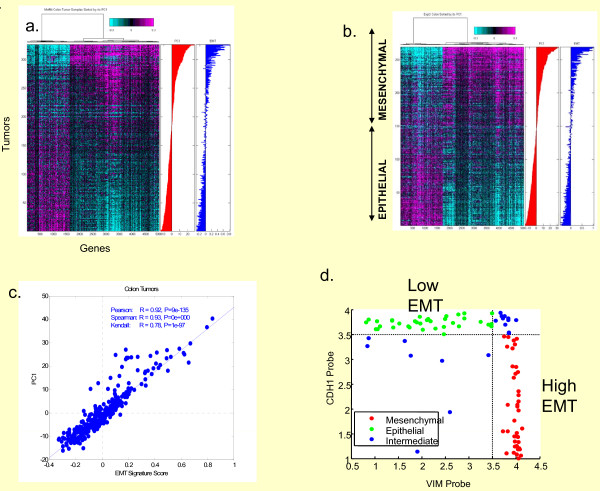
Intrinsic molecular stratification of human colorectal cancer. Unsupervised analysis and hierarchical clustering of global gene expression data derived from colorectal cancer cases identified 2 major "intrinsic" subclasses (cyan and magenta) distinguished by the first principal component (PC1) of the most variable genes. These two key native subtypes were clearly identified in both the (a) Moffitt Cancer Center (MCC) data set (n = 326) and the (b) EXPO dataset (n = 269). PC1 was later found to be tightly correlated with an EMT signature derived from cell lines, providing an explanation for the biology underpinning these two intrinsic classes in both datasets. PC1 clearly distinguishes two subclasses which were subsequently identified as epithelial vs. mesenchymal. On both panels (a) and (b), mean-centered probe intensities are shown, and probes are clustered using Pearson correlation based distance and Ward linkage. Also, rows represent samples, and columns represent array probes. Panel (c) shows scatter plot of EMT signature score and PC1 (First Principal Component Score) on Moffitt Cancer Center data set. Panel (D) shows the scatter plot between probe intensities for Vimentin (VIM) and E-cadherin probes in a panel of 93 Lung Cancer Cell Lines. Cell Lines exhibiting epithelial-like phenotype are shown in green; those exhibiting mesenchymal-like phenotype are shown in red.